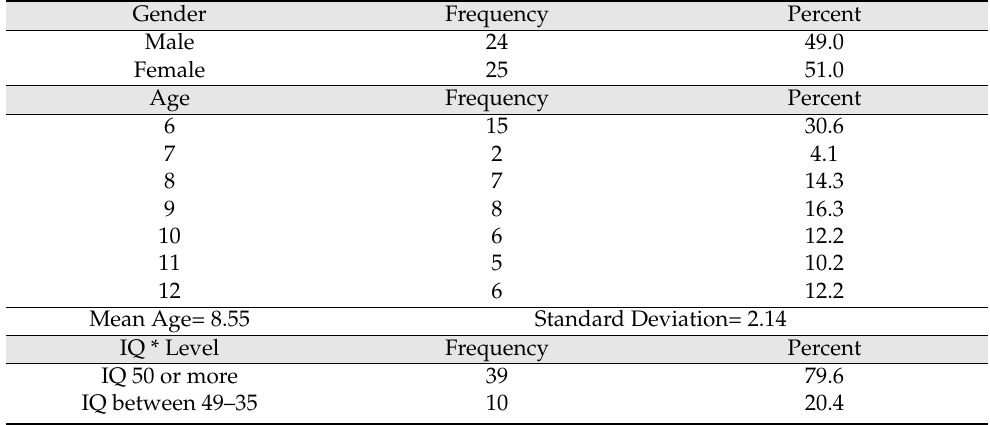
Table 2. Descriptive information about C-DS.